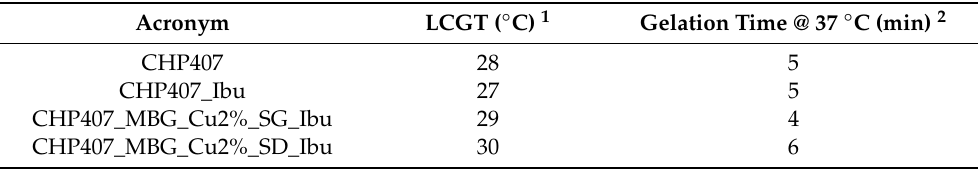
Table 3. Lower critical gelation temperature (LGCT) and gelation time at 37 ◦ C of CHP407,